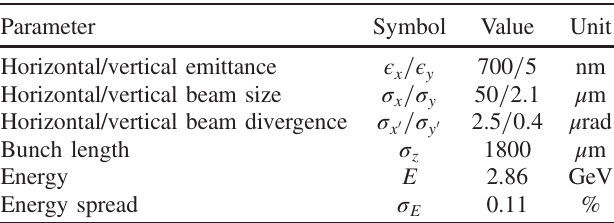
TABLE I. Parameters of the beam extracted from the DR. Parameter Symbol